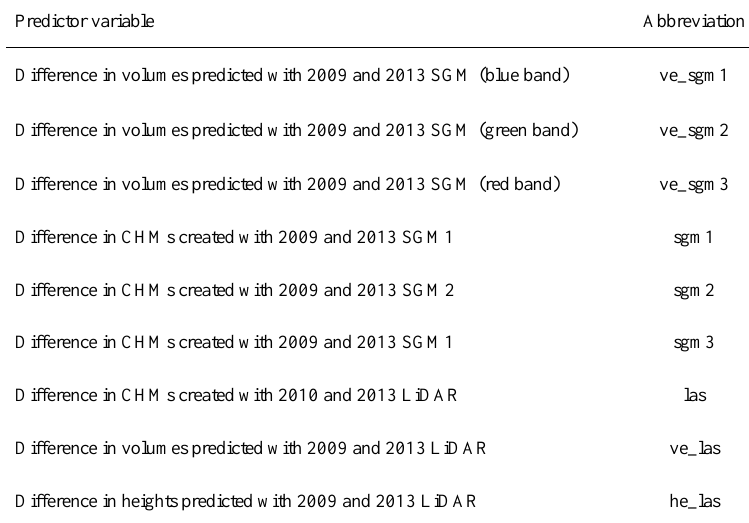
Table 2. The most important predictor variables and their abbreviations.